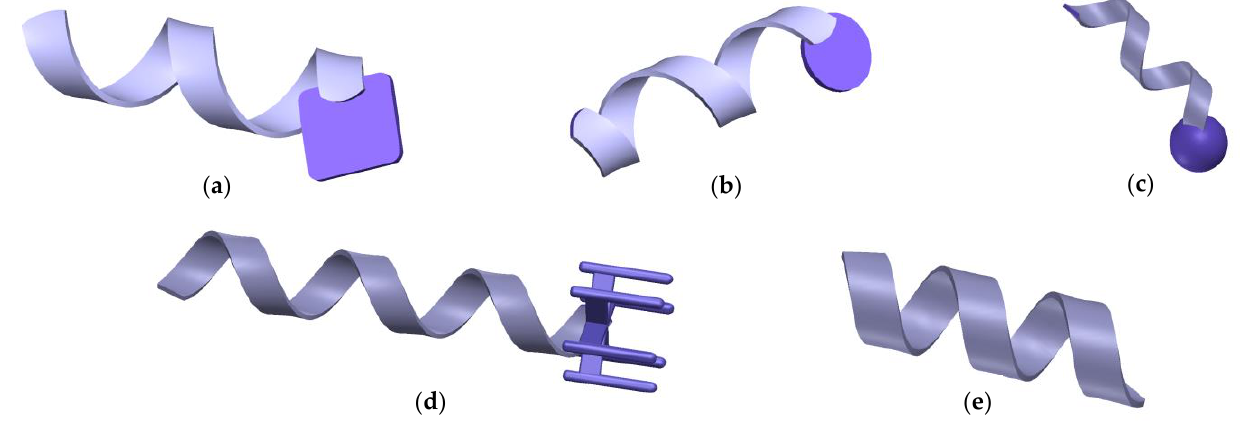
Figure 2. Helical microrobots: ( a ) With a soft magnetic head; ( b ) having a head with a microholder; ( c ) with a spherical head; ( d ) with a circular head; ( e ) without a head.